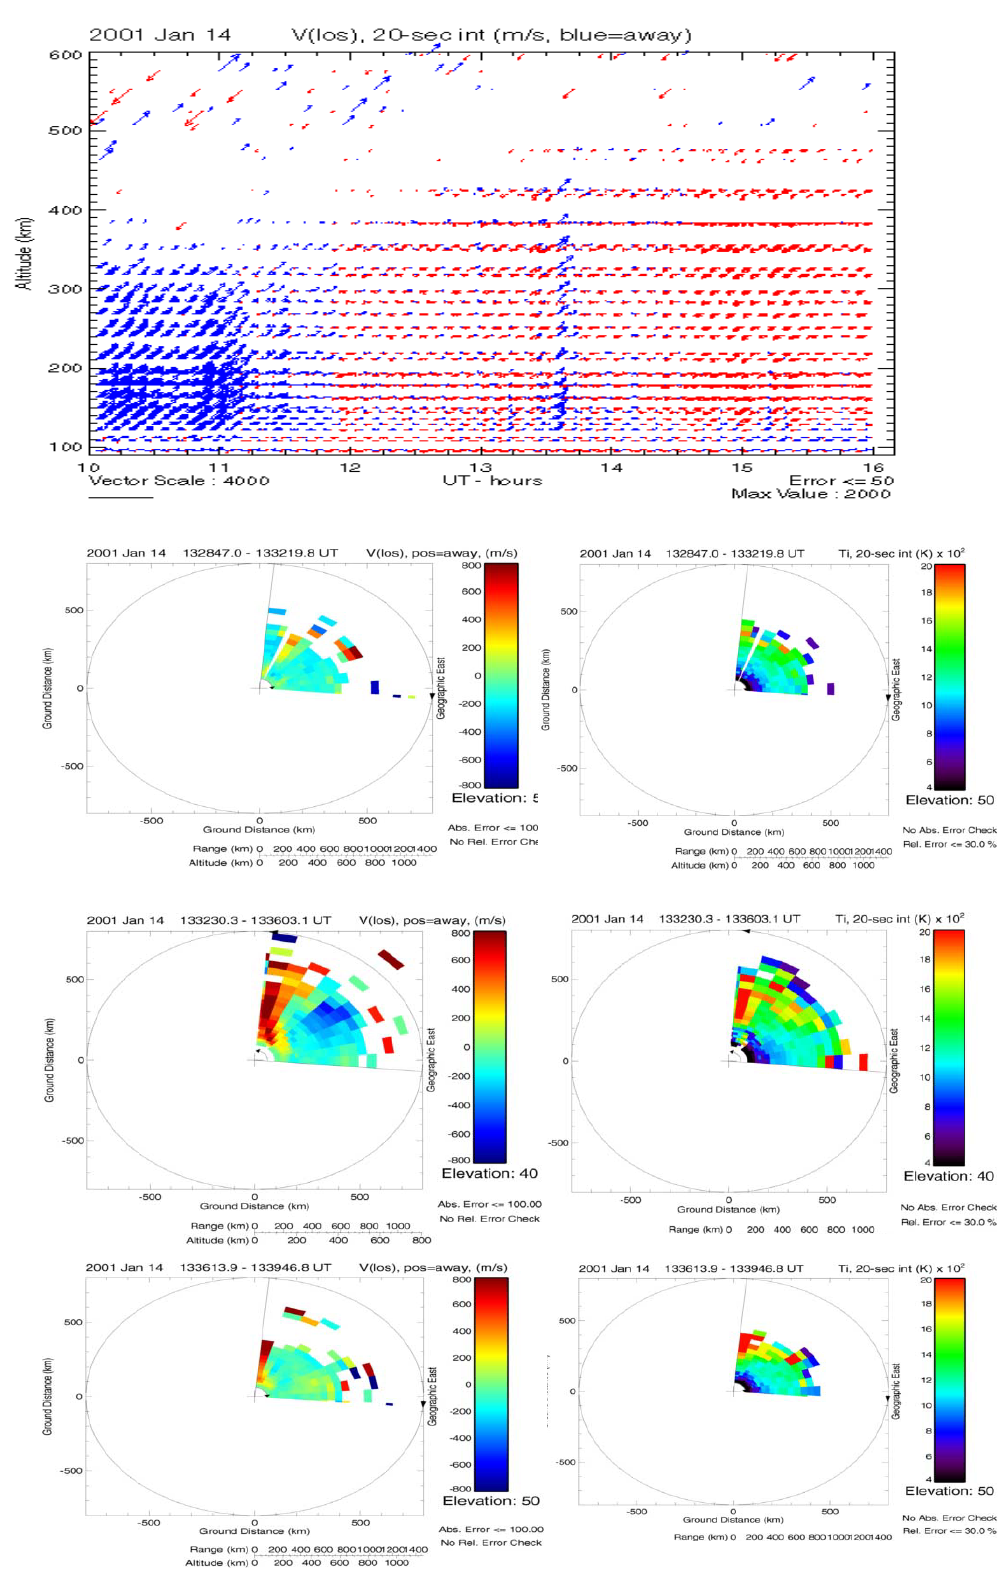
Fig. 11. Top panel: overview presentation of STF line-of-sight measurements along an azimuthal scan in the northeastern quadrant, plotted versus altitude and time (blue vectors represent flow away from the radar and red vectors represent flow towards). Bottom left panels: line- of sight plasma velocity measurements (red = away) for three consecutive scans from 13:28–13:47. Bottom right panels: ion temperature measurements (red = high T i ) for three consecutive scans from 13:28–13:47. North is to the top of the scan plots and east to the